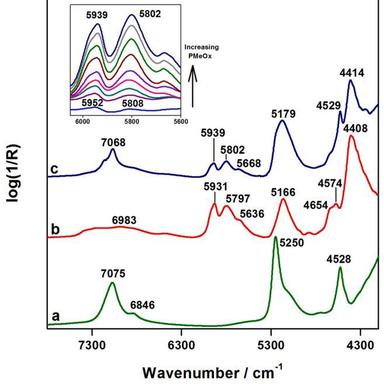
NIR spectra of Na-Mt, neat PMeOx and PMeOx-Mt prepared with 850 mg of PMeOx per 1 g of Mt (PMeOx 850-Mt). Insert: CH-overtone region of PMeOx-Mt prepared with different initial amounts of PMeOx, increasing from the bottom (PMeOx 9-Mt) to the top (PMeOx 850-Mt).